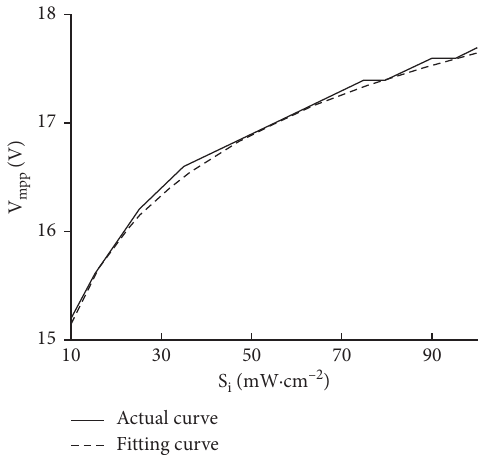
Figure 3: The actual curve and fitting curve between V